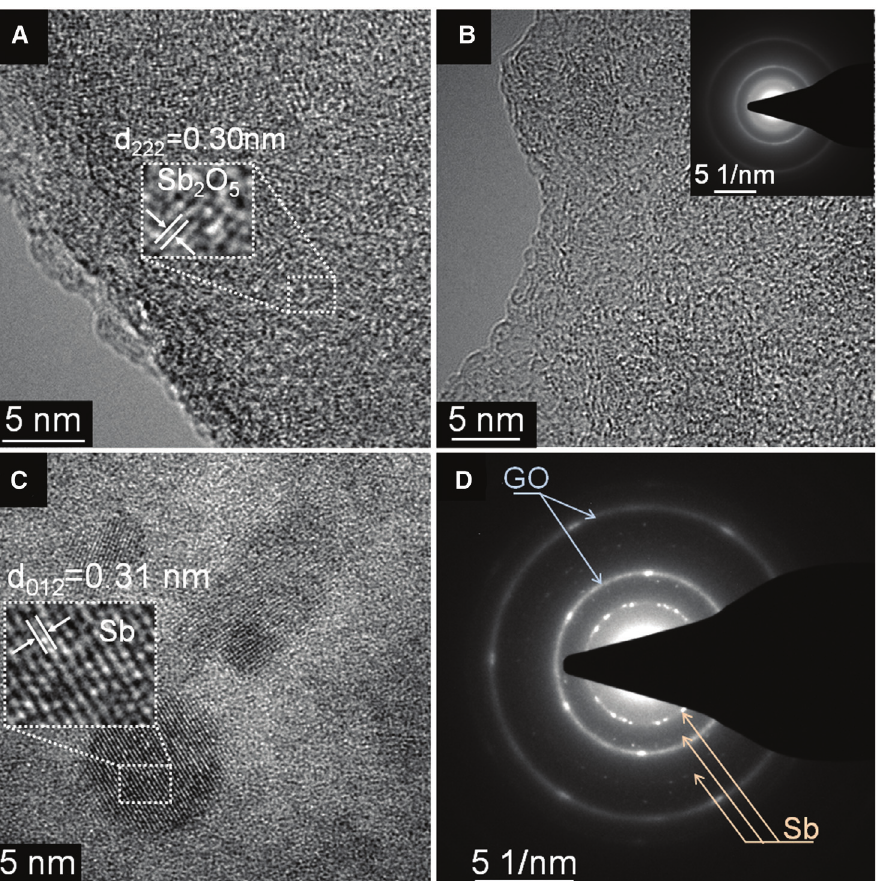
Figure 2: TEM images of antimony (V) oxide at room temperature with an insert that depicts nanocrystalline phases (A), rGO-Sb-300 (B) and rGO-Sb-650